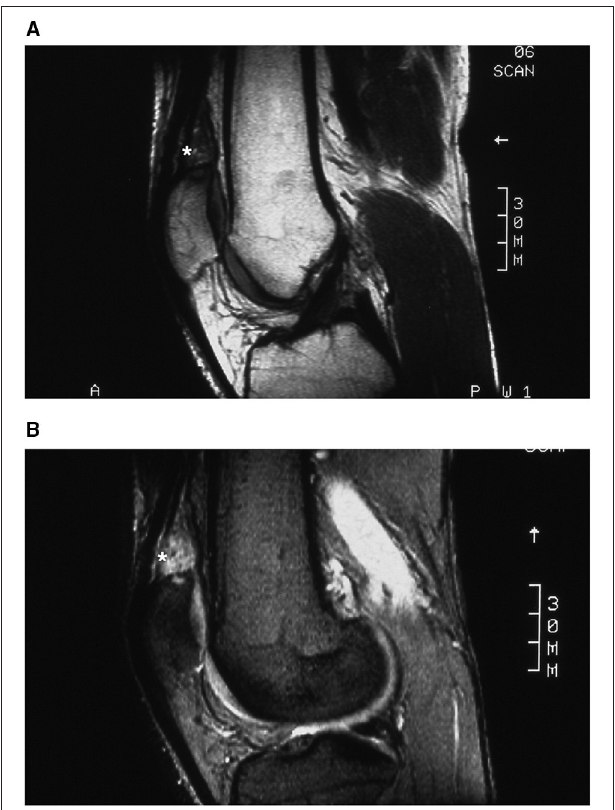
FIGURE 4 | Case 2: suprapatellar SH MRI. Isointense T1 (A) and hyperintense T2 (B) sagittal MR images showing a synovial tumor just over the proximal pole of the patella with intra-osseous invasion of the upper pole of the patella. *Location of the Synovial Haemangioma tumor in the